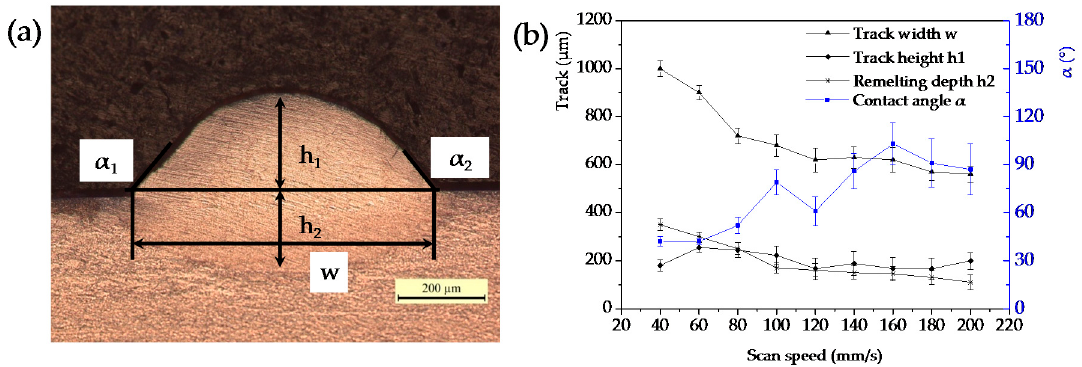
Figure 4. ( a ) Measurement of the cross section of the scan track geometry; ( b ) the geometrical characteristics of synthesized single tracks as a function of scanning speed.